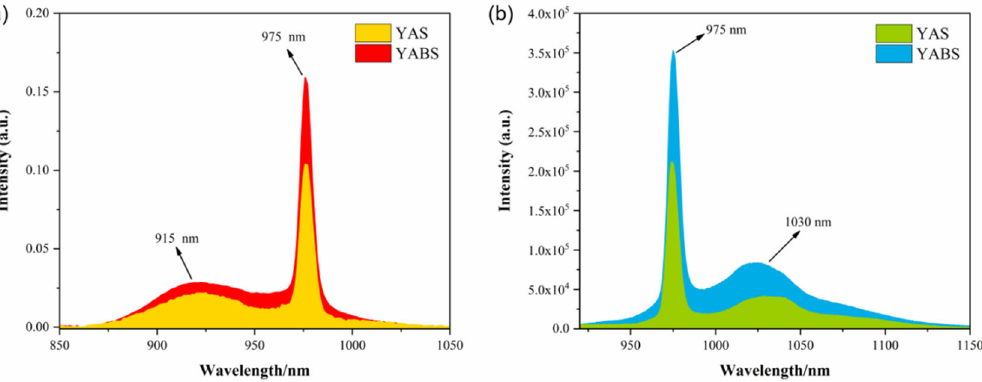
Figure 6. 2D ‐ HYSCORE spectra recorded at a magnetic field of 600 mT for YABS glass.